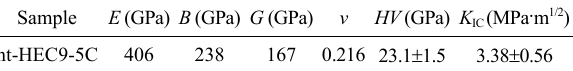
Table 4 Physical properties of ht-HEC9-5C ceramics sintered at 1800 ℃